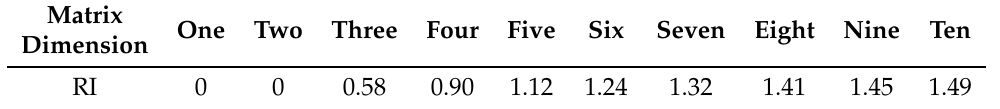
Table 2. The table of Random Index